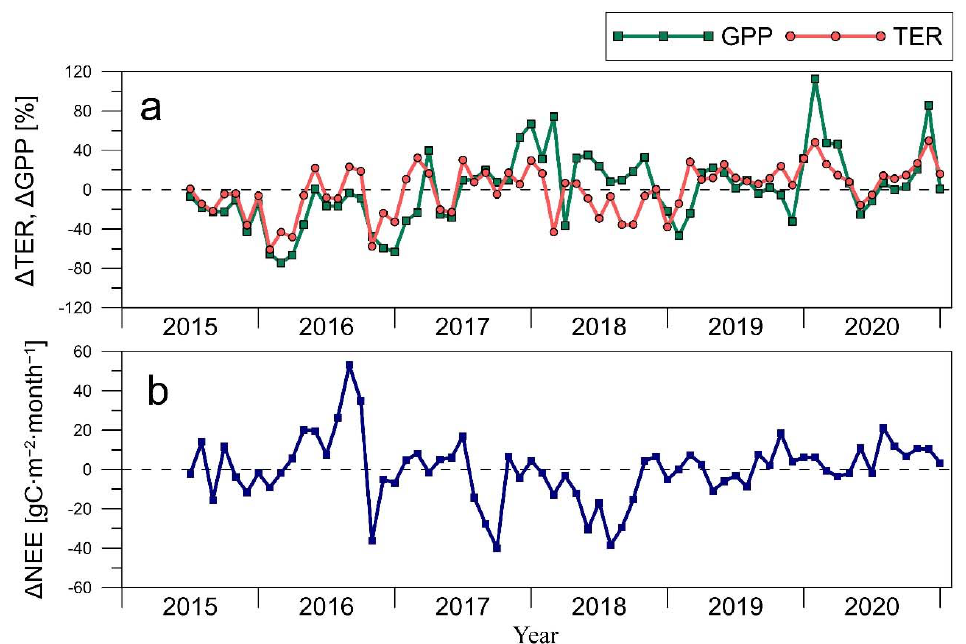
Figure 4. ( a ) Relative monthly flux anomalies of the gross primary production (GPP) and total ecosystem respiration (TER) as well as ( b ) absolute anomalies of the monthly net ecosystem exchange (NEE) in the 2015–2020 period.